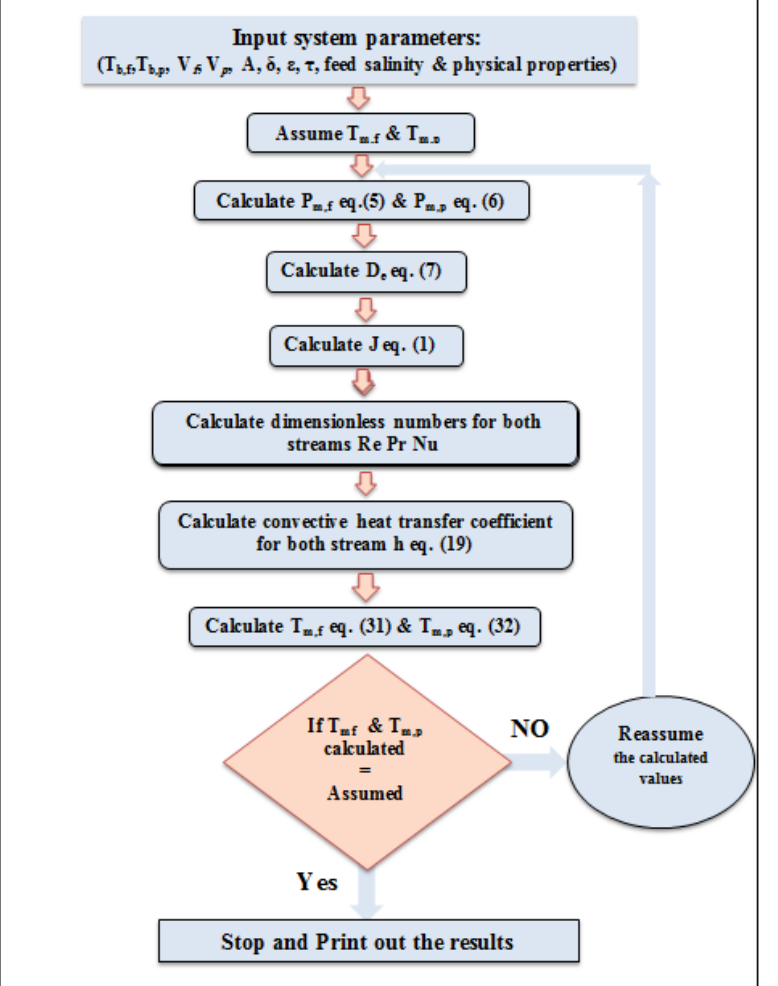
Figure 2. Algorithm of the proposed model.